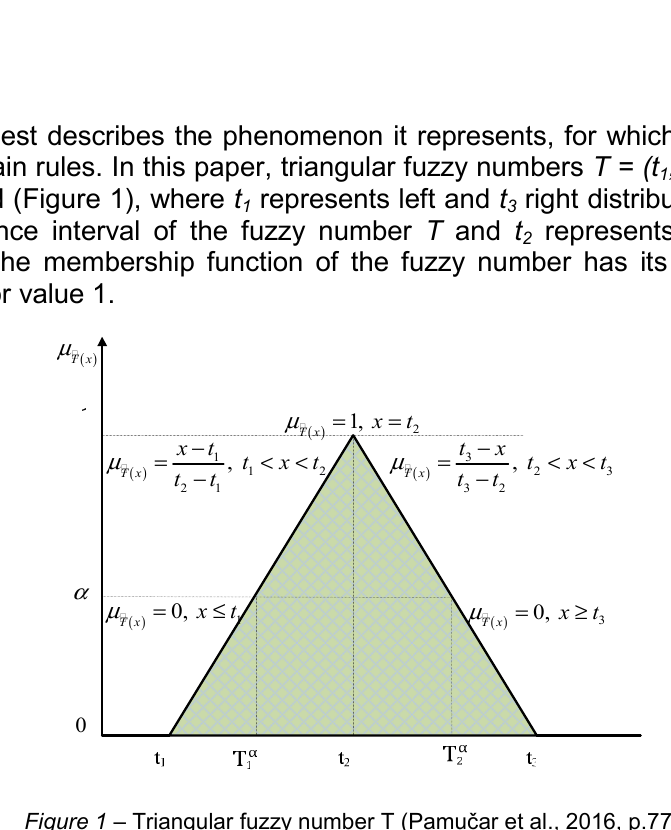
Figure 1 – Triangular fuzzy number T (Pamu č ar et al., 2016, p.77) Фигура 1 – Треугольное нечеткое число T (Pamu č ar i dr., 2016, p.77) Slika 1 – Trouglasti fuzzy broj T (Pamu č ar i dr., 2016, p.77 ) The elements of fuzzy sets are taken from the confidence